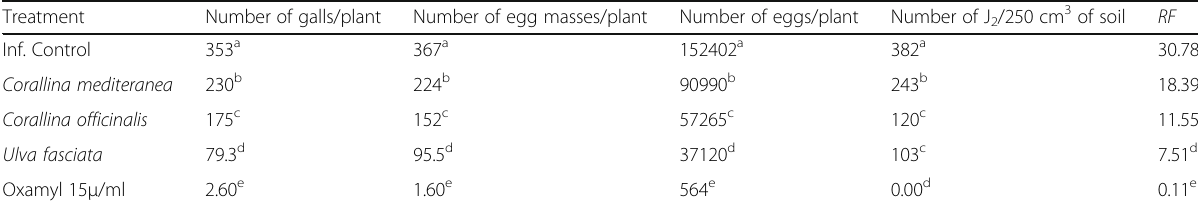
Table 3 Effect of three marine algal extracts against the root-knot nematode, Meloidogyne incognita galls, egg masses, eggs on roots, and second stage J 2 population in soil of tomato plants under greenhouse conditions Treatment Number of